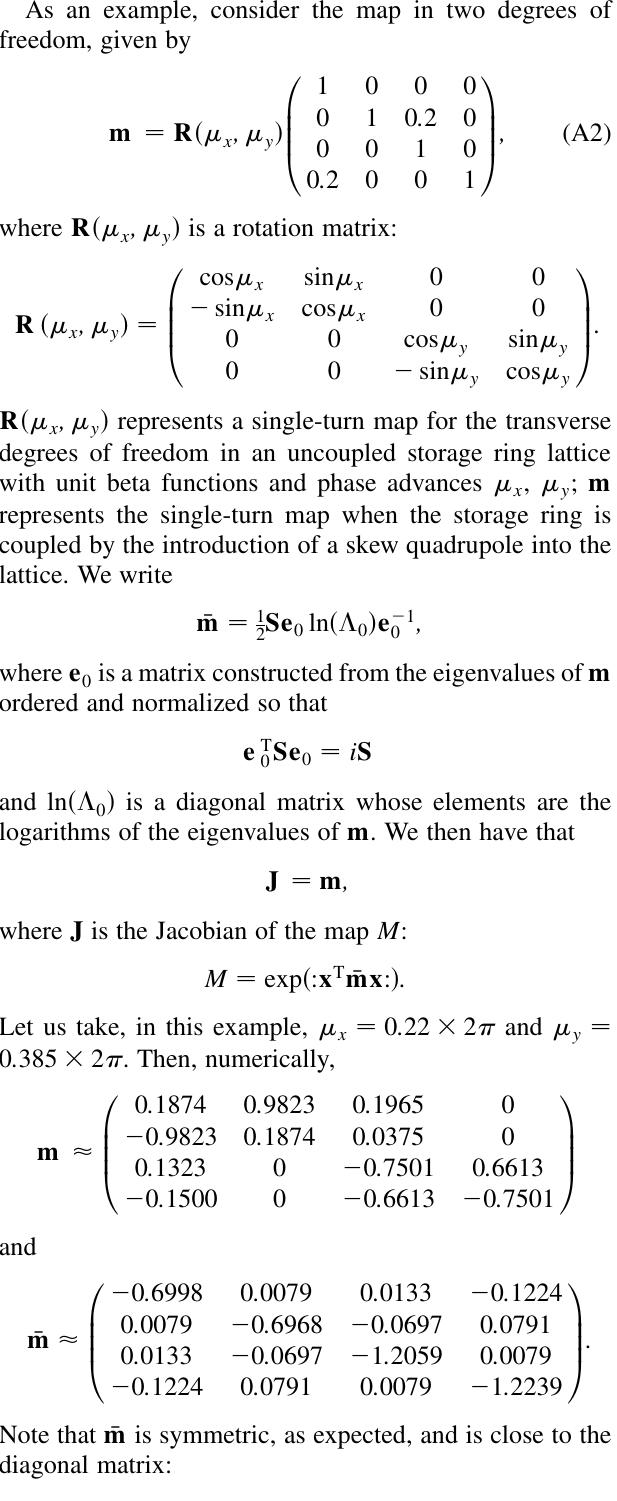
FIG. 4. (Color) Linear decoupling. Points showing the trajectory using the original coupled map are plotted in black. The same points, with a decoupling transformation applied, are plotted in